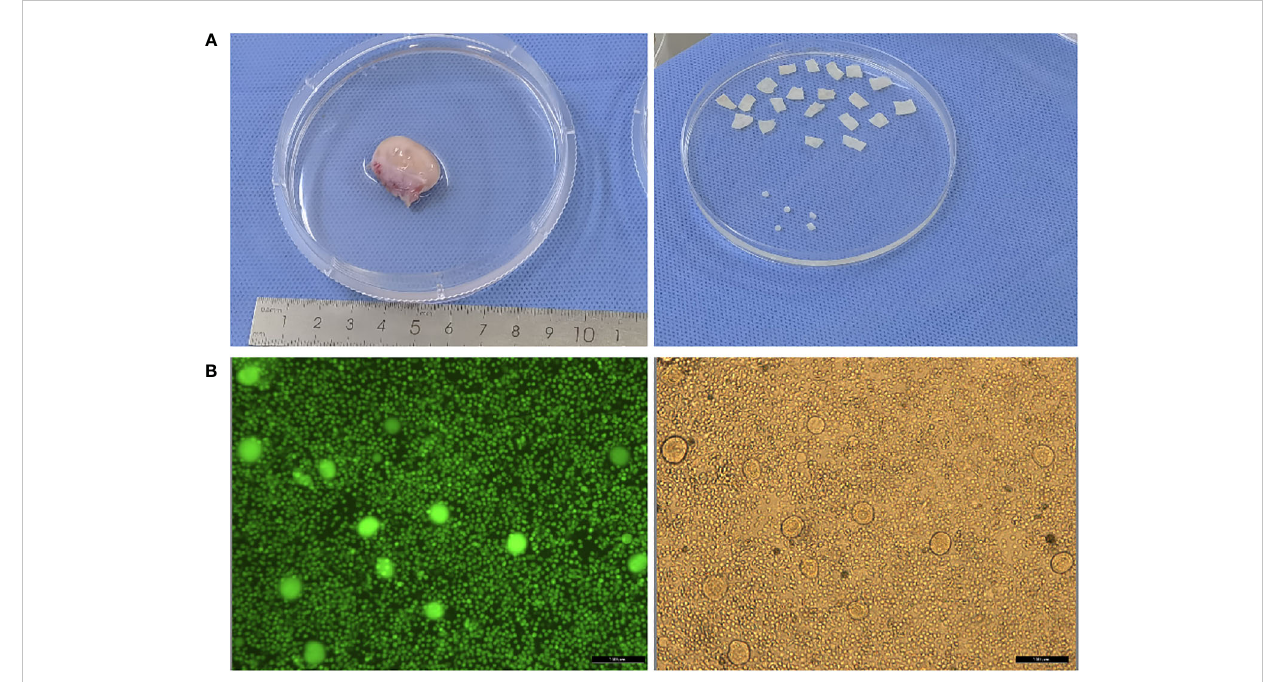
FIGURE 1 (A) Photos of ovary before and after ovarian tissue cortex preparation; (B) Detection of follicular activity in ovarian